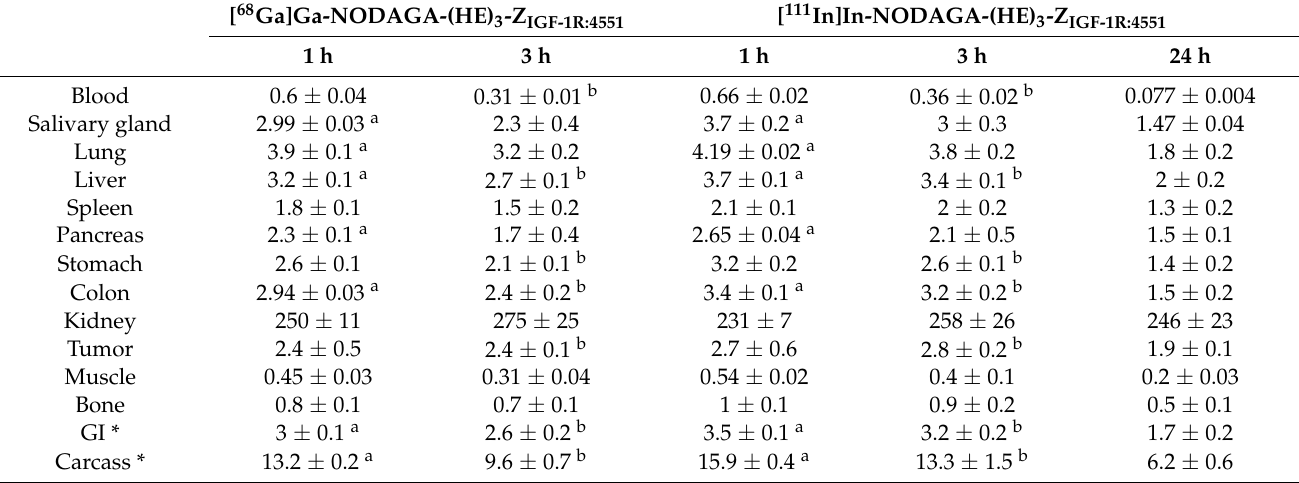
Table 2. Biodistribution of [ 68 Ga]Ga-NODAGA-(HE) 3 -Z IGF-1R:4551 and [ 111 In]In-NODAGA-(HE) 3 - Z IGF-1R:4551 in BALB/C nu/nu mice bearing DU145 xenografts.